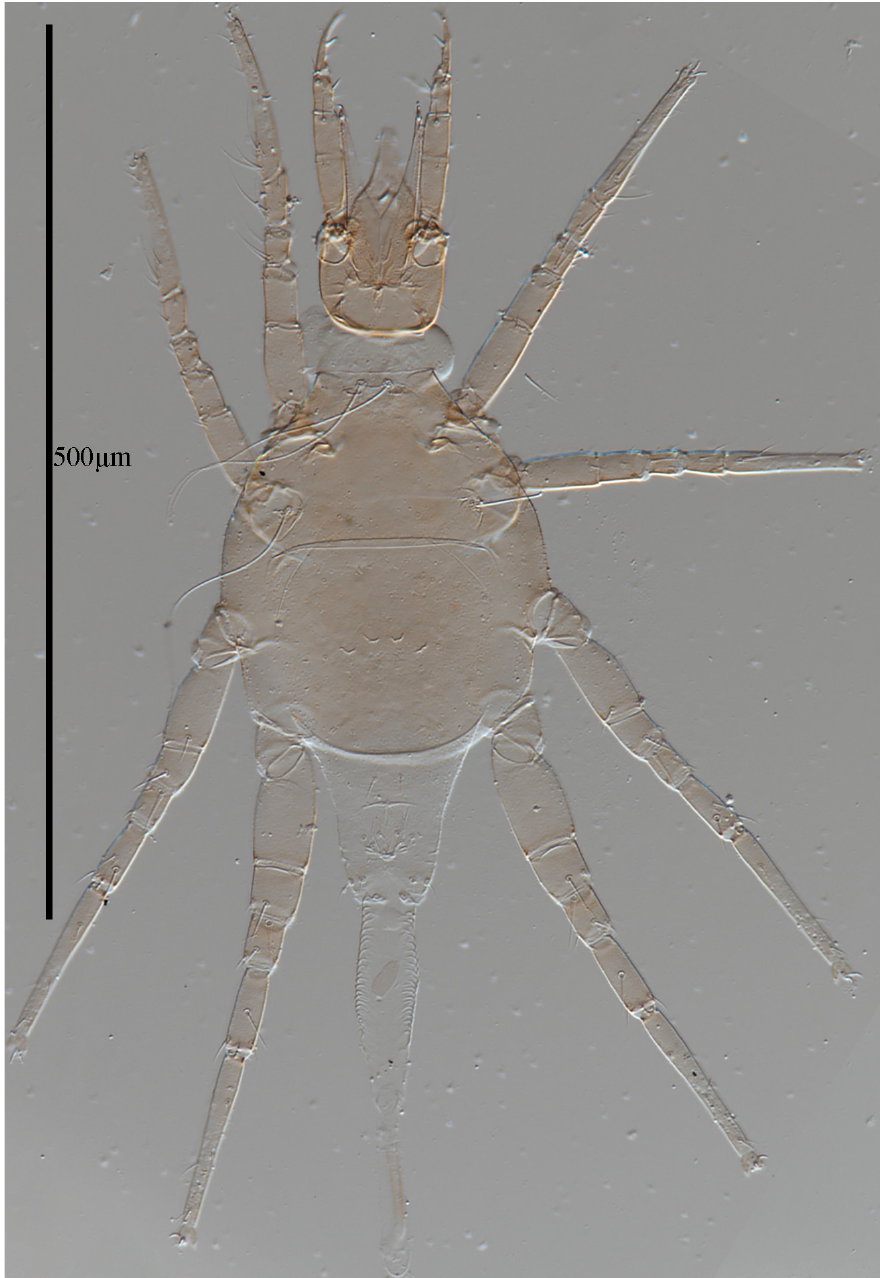
Figure 1. Cunaxicaudus mohanensis sp. nov . (male). Entire specimen (photo). Scale bar = 500 µm.